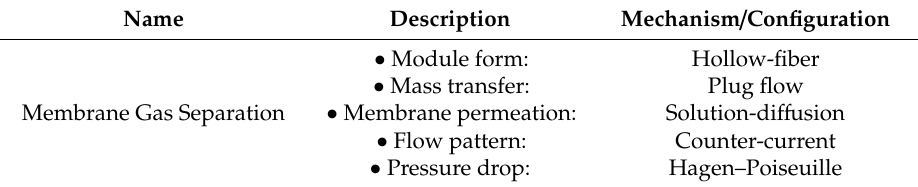
Table A3. Assumptions for